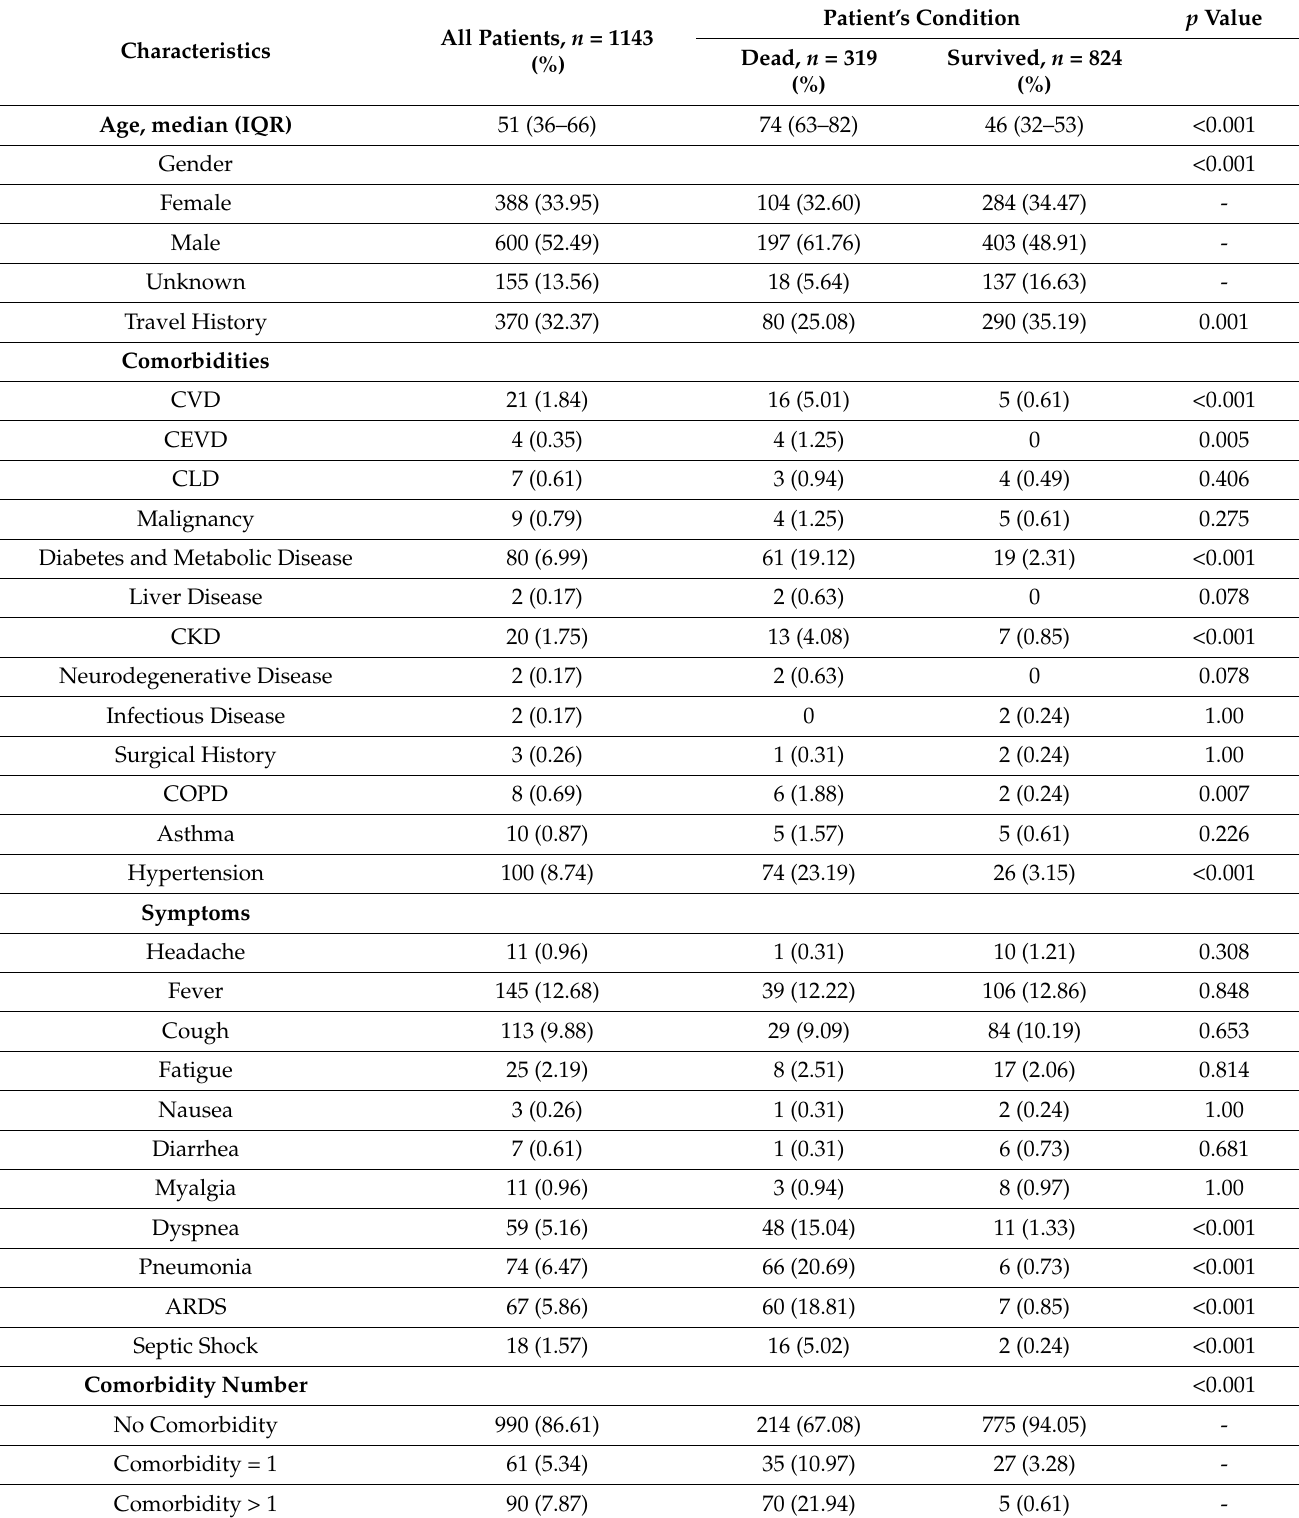
Table 5. Association between patient survival and selected demographic characteristics, comorbidities and clinical symptoms.